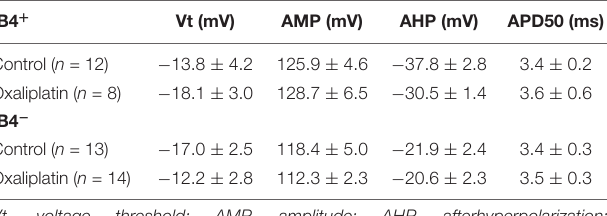
TABLE 1 | Shape properties of action potentials in the absence and presence of